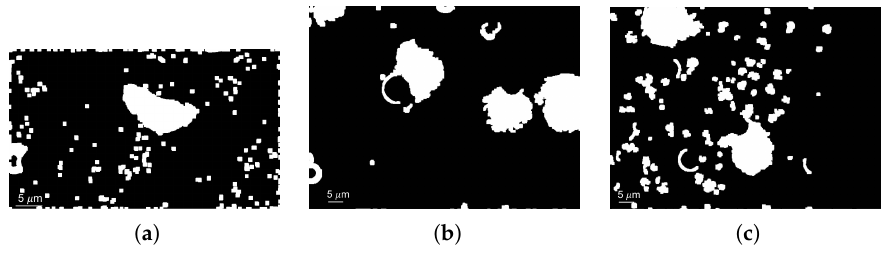
Figure 11. Result of the addition of dilated image and bitwise NOT on the floodfilled bright field images shown in Figure 10: ( a ) I iw